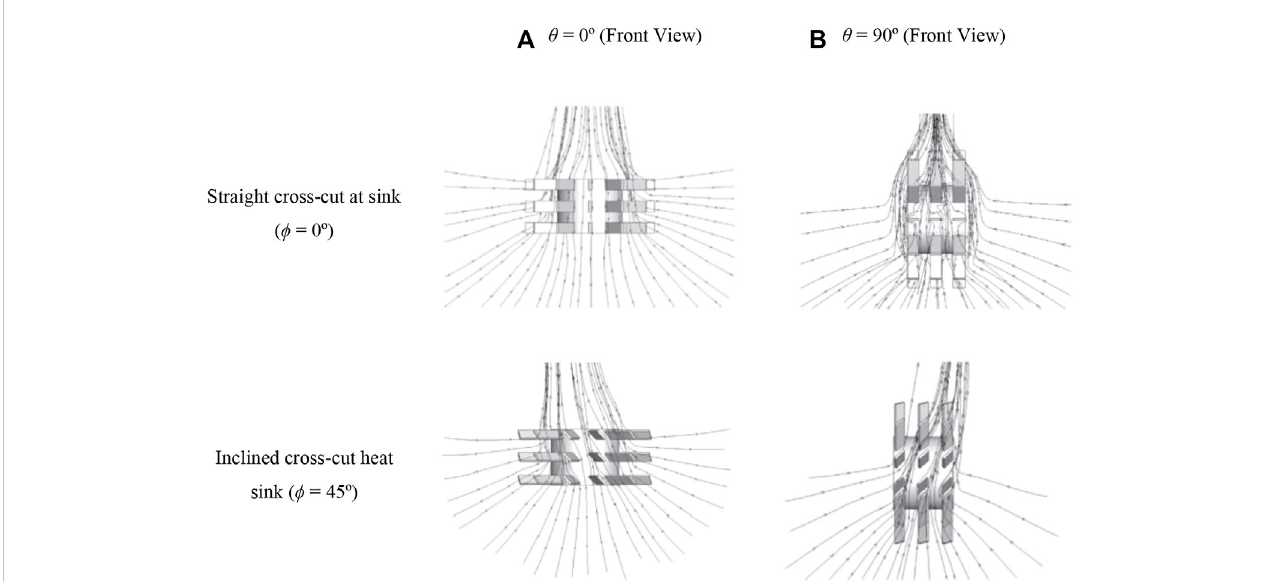
FIGURE 9 Fluid fl ow lines around a cylindrical heat sink for various installation angles (Q = 5000W/m 2 , T1 = 26 ° C). (A) θ = 0 ° (Front View). (B) θ = 90 ° (Front View). Straight cross-cut at sink ( ϕ = 0 ° ). Inclined cross-cut heat sink ( ϕ = 45 ° ) (Park and Lee,